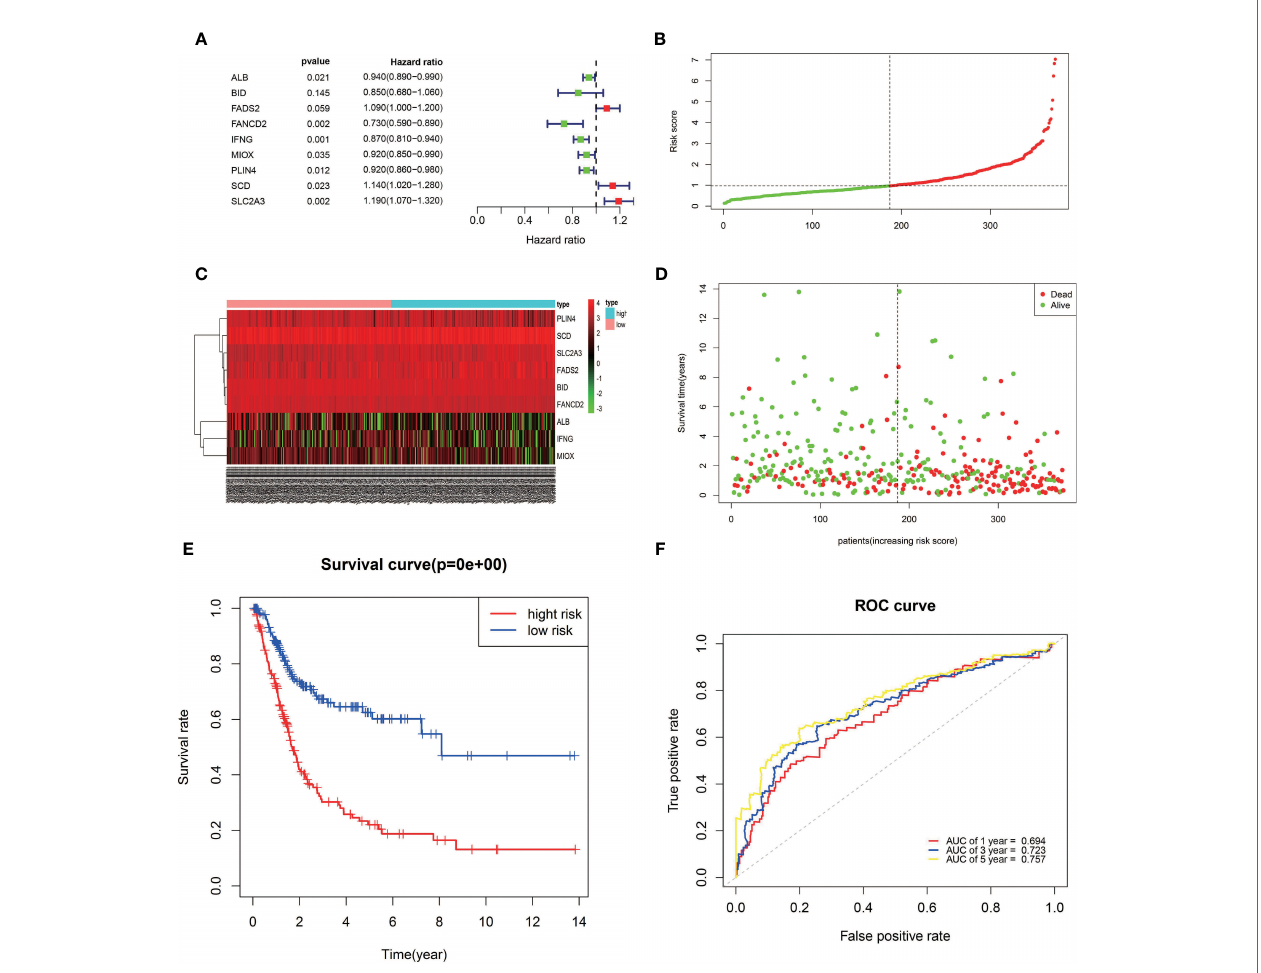
FIGURE 3 | Establishment of a prognostic model of FRGs in the TCGA cohort. (A) A nine-gene signature was generated by Multivariate Cox regression analysis. (B) Distribution of signature-based risk scores. (C) The differences in the expression of the prognostic signature in different risk groups. (D) Survival status of high- risk and low-risk patients. (E) Kaplan – Meier curves indicated that the OS in the high-risk group was markedly poorer than that in the low-risk group ( p < 0.0001). (F) Time-dependent ROC curve analysis for measuring the prognostic performance of the signature-based risk score on